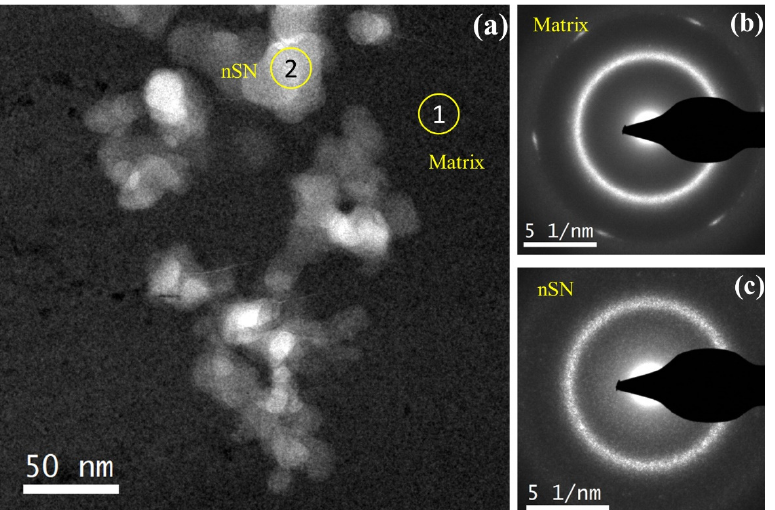
Figure 4. ( a ) TEM image of Ni-P-nSN composite coating; ( b ) the SAED pattern obtained from the matrix region indicated by ‘1’; ( c ) the SAED pattern obtained from the particle indicated by ‘2’. The SAED patterns for both matrix and nSN particles are diffused circular rings, indicating both are in the amorphous phase. In addition, the interface separating the particle and matrix can easily be distin- guished in Ni-P-SN specimen but diffused in the Ni-P-nSN due to the amorphous nature